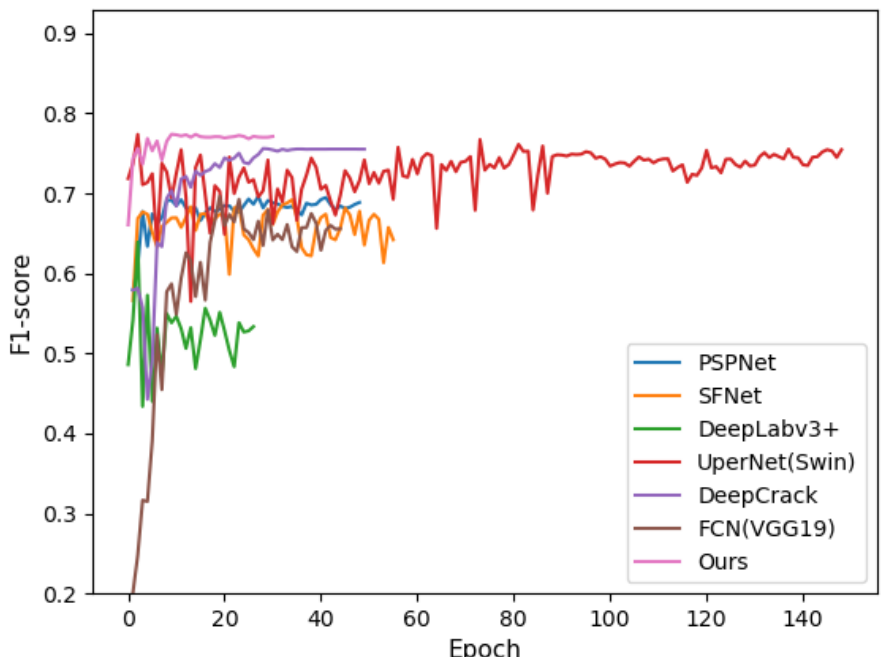
Figure 7. Validation F1-score of different models on Crack500